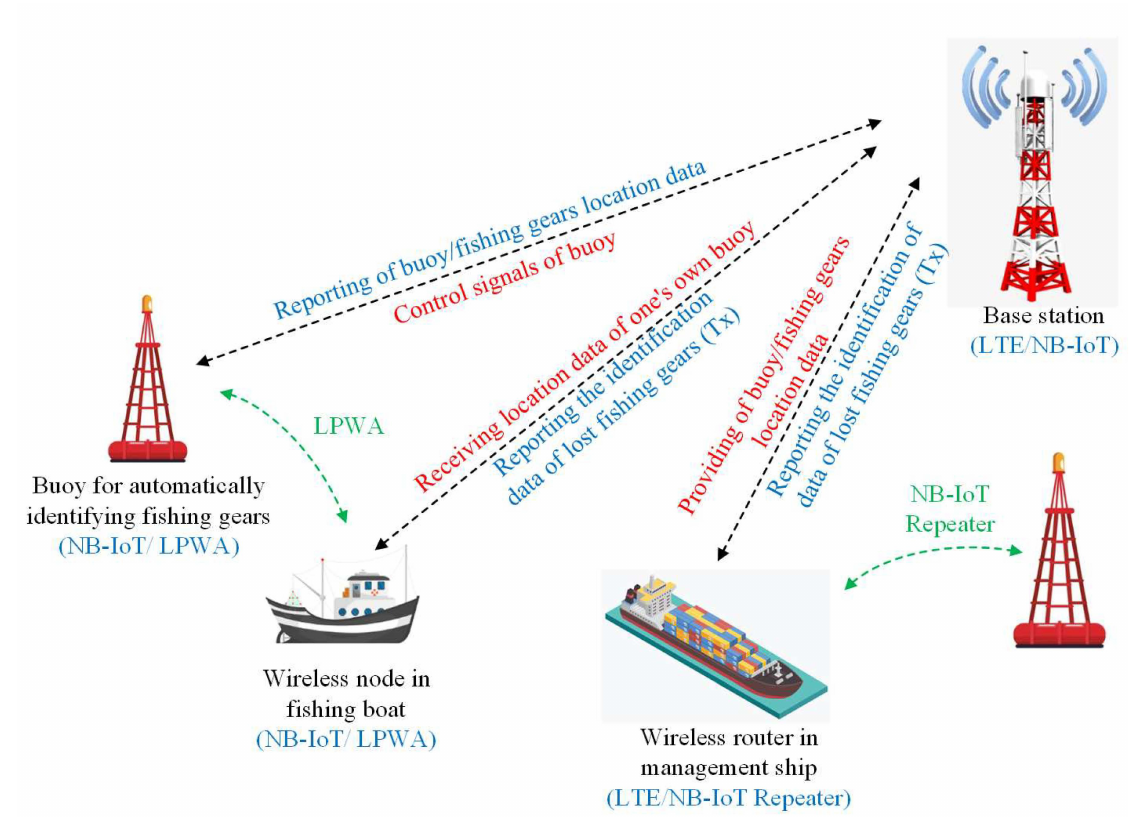
Figure 1. Illustration of marine IoT for fishing gear automatic identification